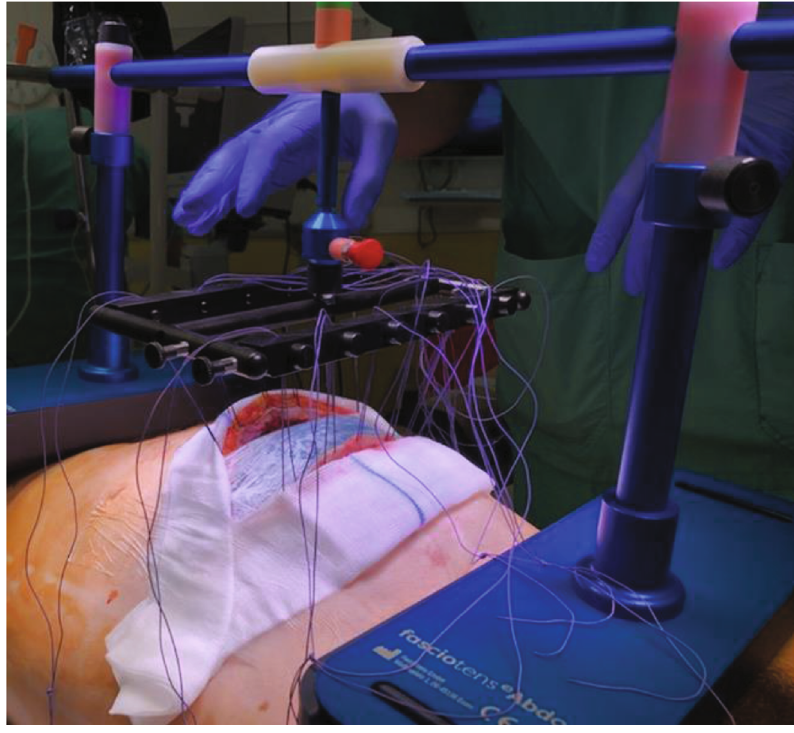
Figure 3: Application of Fasciotens